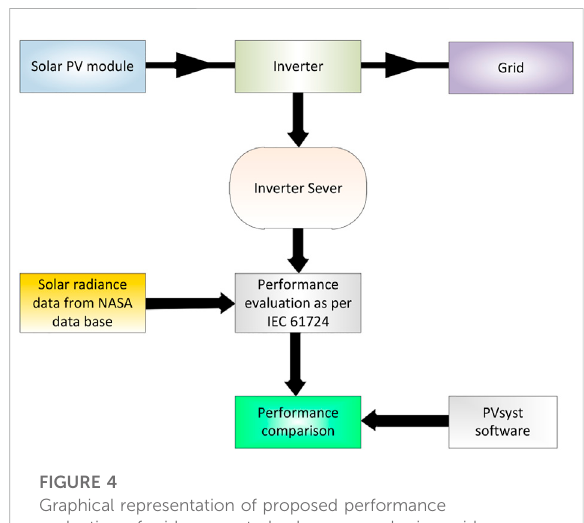
FIGURE 4 Graphical representation of proposed performance evaluation of grid-connected solar-powered